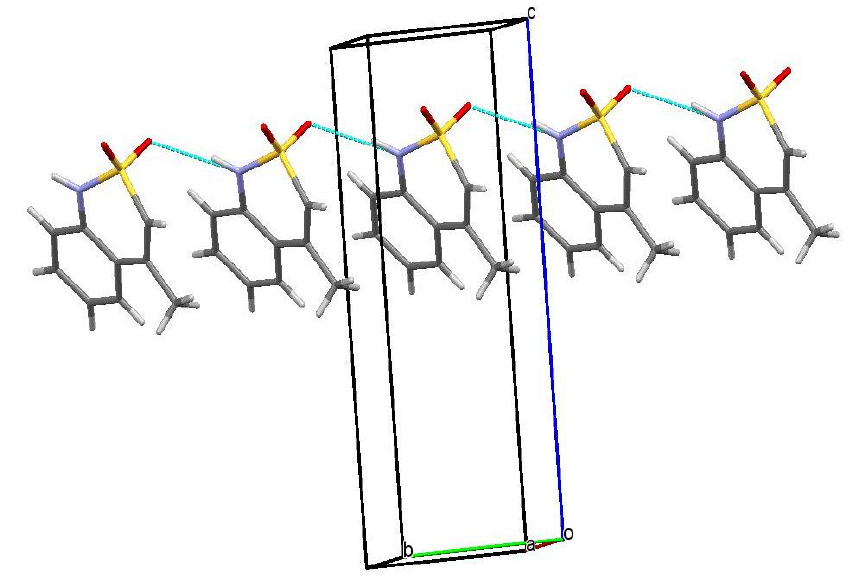
Figure 9. The chain of benzothiazine 7 molecules bound by hydrogen bonds.